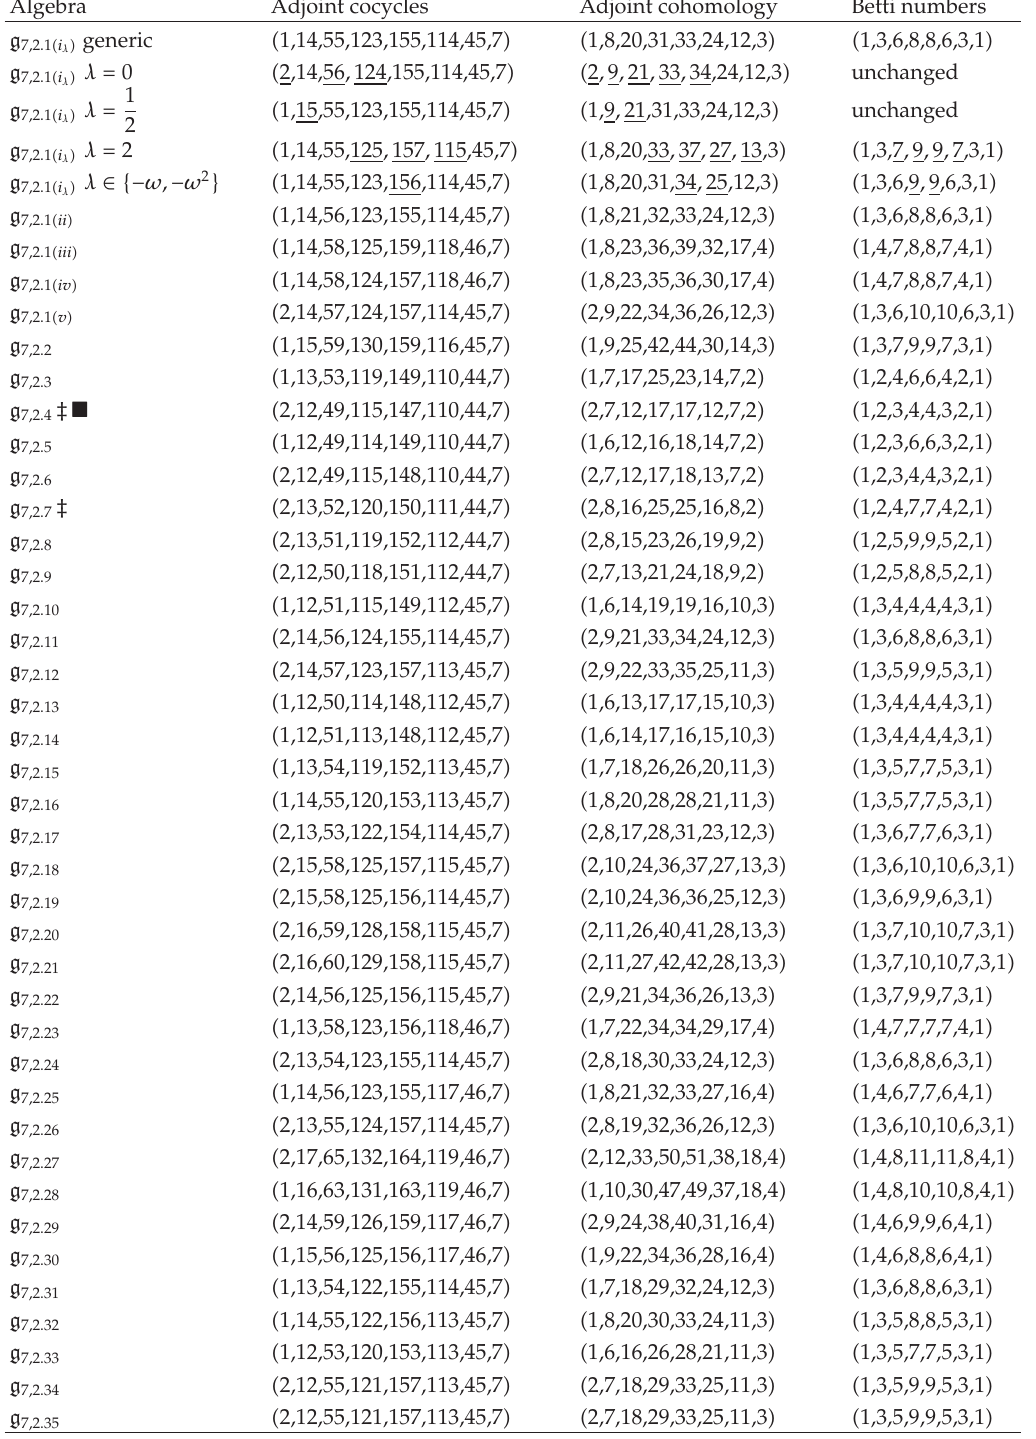
Table 5: Cohomology table for NLAs of dimension 7: rank 2. (cid:2) continues on next page (cid:3) . Algebra Adjoint cocycles Adjoint cohomology Betti